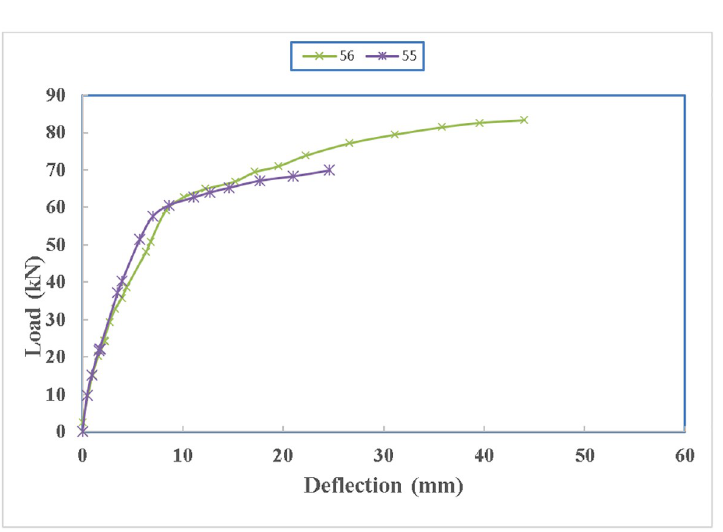
Fig 27. Load- deflection diagram between beam 55 and beam